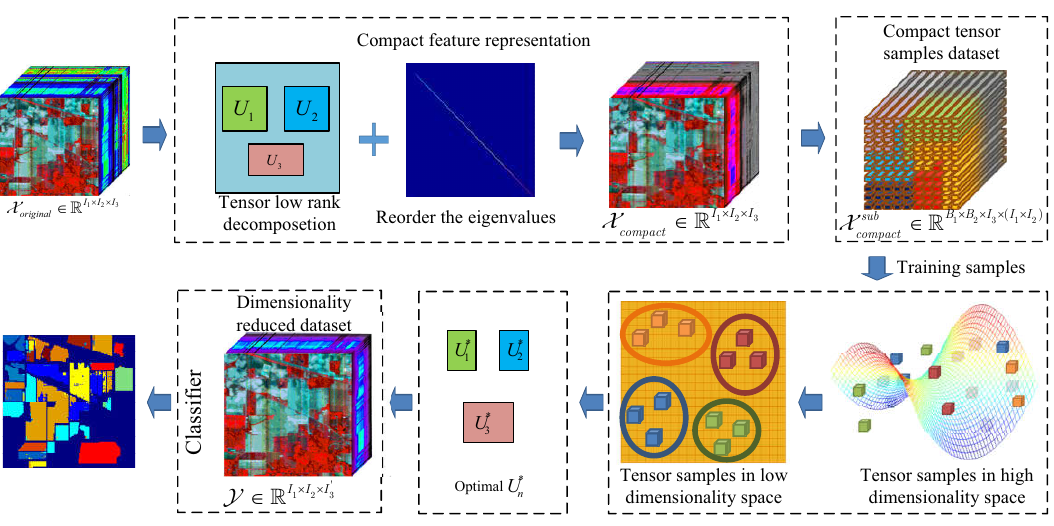
Figure 1. The flowchart of the proposed